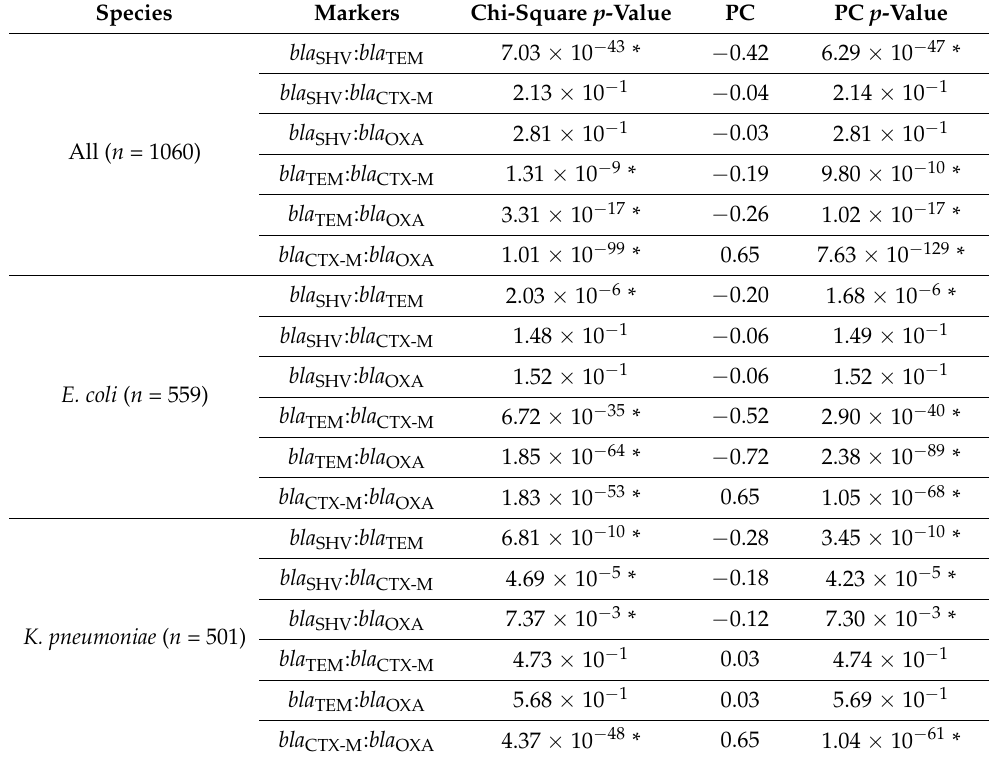
Table 4. Linkage analysis summary for the Nationwide Database Isolates. The p -value for a chi- square test for linkage, the phi coefficient, and the associated p -value are presented for each resistance marker pair comparison. The number of isolates for each species is given in parenthesis. An asterisk (*) indicates a statistically significant comparison after the FDR-controlling procedure ( q * = 0.025) for both the chi-square test and the phi